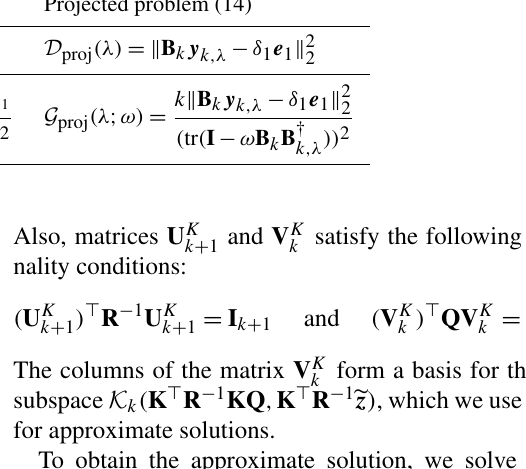
Table A1. Regularization parameter selection methods for use within genHyBR methods. Methods Original problem (11) Projected problem